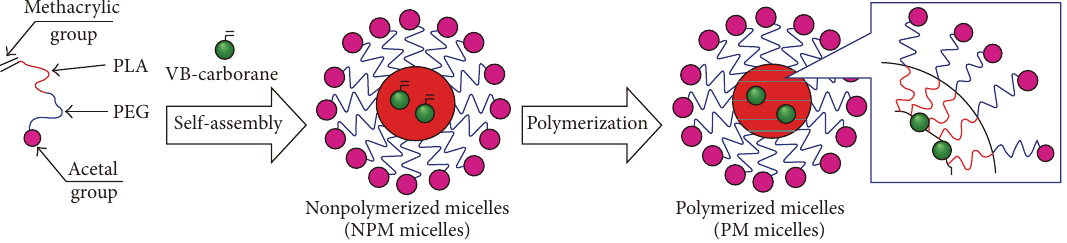
Figure 5: Schematic illustration of 10 B-enriched micelle preparation from acetal-PEG- b -PLA-MA and polymerizable VB-carborane. ReprintedfromBiomaterials, 2012,33, 3568-3577. S. Sumitani,M.Oishi, T.Yaguchi, H. Murotani,Y.Horiguchi, M.Suzuki, K.Ono, H.Yanagie, and Y. Nagasaki. “Pharmacokinetics of core-polymerized, boron-conjugated micelles designed for boron neutron capture therapy for cancer.” Copyright (2012), with permission from